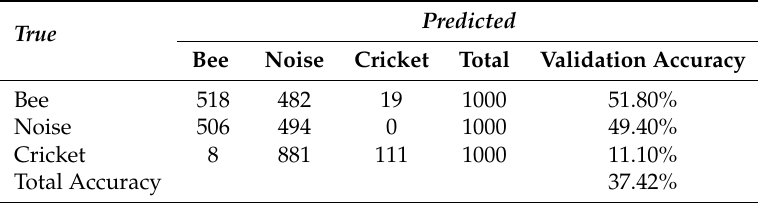
Table A17. Confusion matrix for SVM OVR on BUZZ2 validation